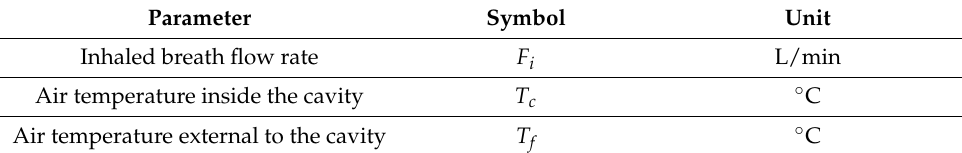
Table 1. Cont. Parameter Symbol Unit Inhaled breath flow rate F i L/min Air temperature inside the cavity T c ◦ C Air temperature external to the cavity T f ◦